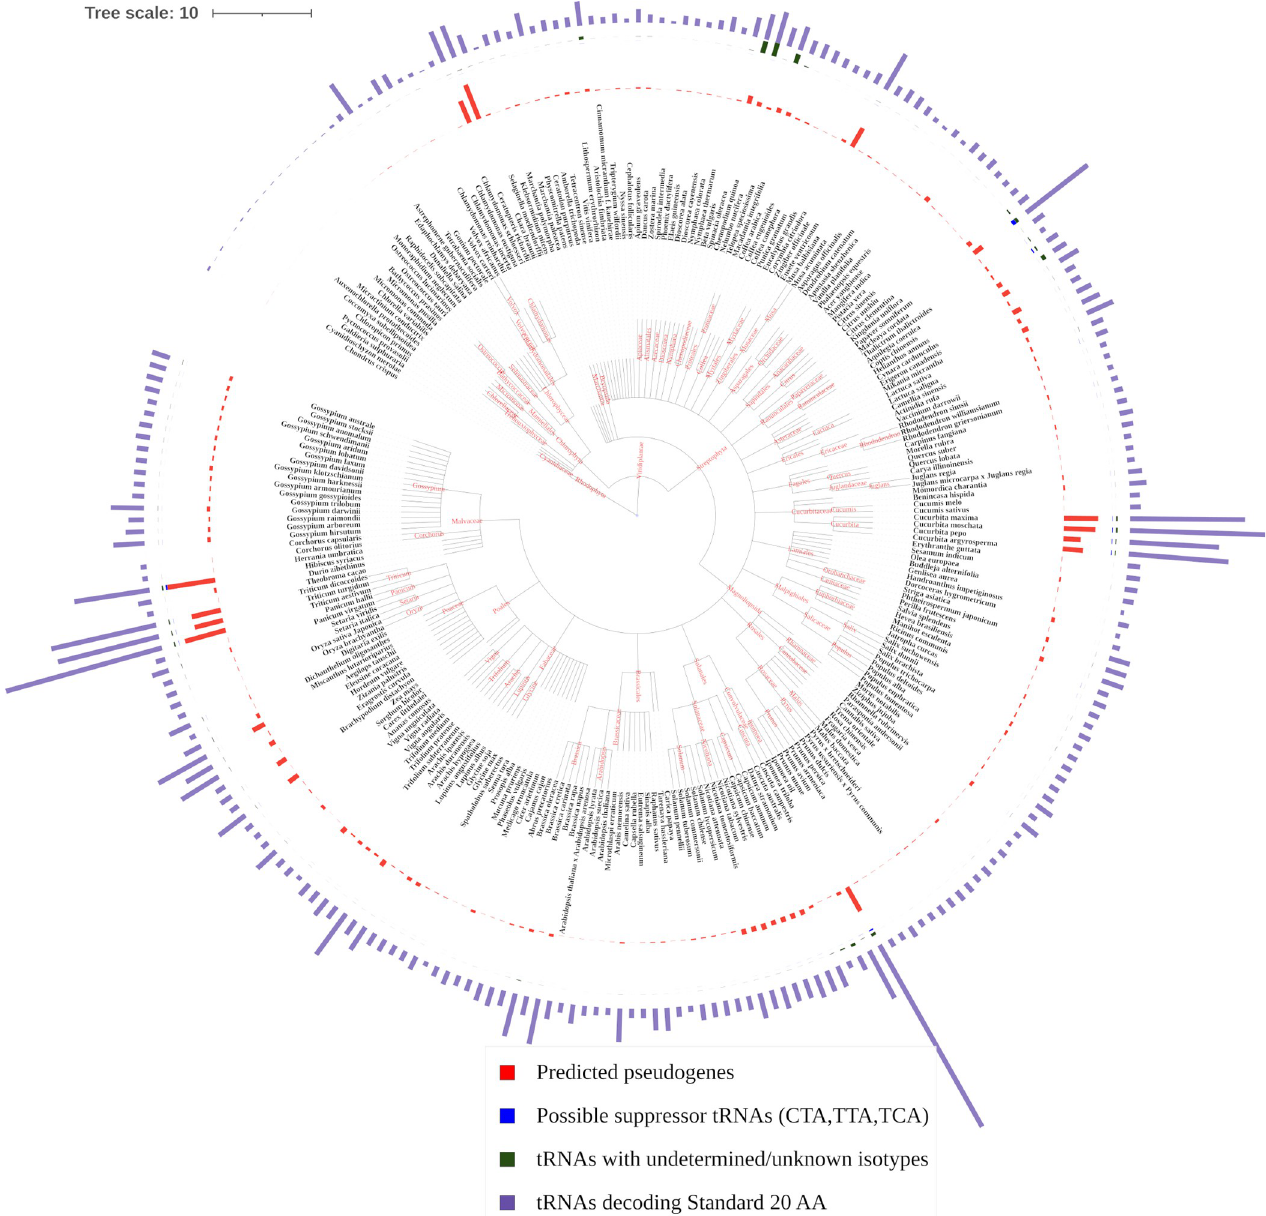
Fig 2. The bar chart represents the comparisons of nuclear genomes of the studied plant species. The inner circle represents 256 plant species, and the outer circle includes tRNA decoding the standard 20 amino acids (purple color), predicted pseudogenes (red color), possible suppressor tRNAs (blue color), and tRNA with undetermined isotypes (green